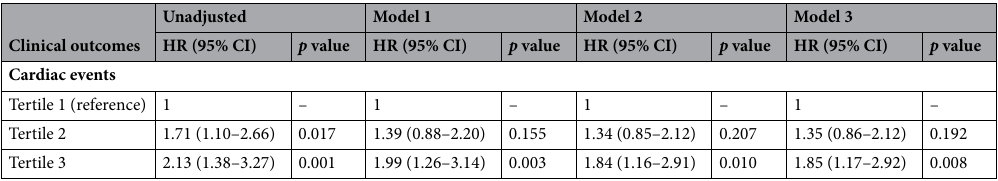
Table 5. Univariable and multivariable analyses of gamma-glutamyl transferase levels for cardiac events, corrected for clinical risk factors. HR hazards ratio; CI confidence interval. Model 1 was adjusted for age and sex; model 2 was adjusted further for diabetes mellitus, hypertension, hyperlipidemia, and current smoking; and model 3 was adjusted further for body mass index (kg/m 2 ), creatinine, uric acid, family history of coronary artery disease, and high-sensitivity C-reactive protein ≥ 2